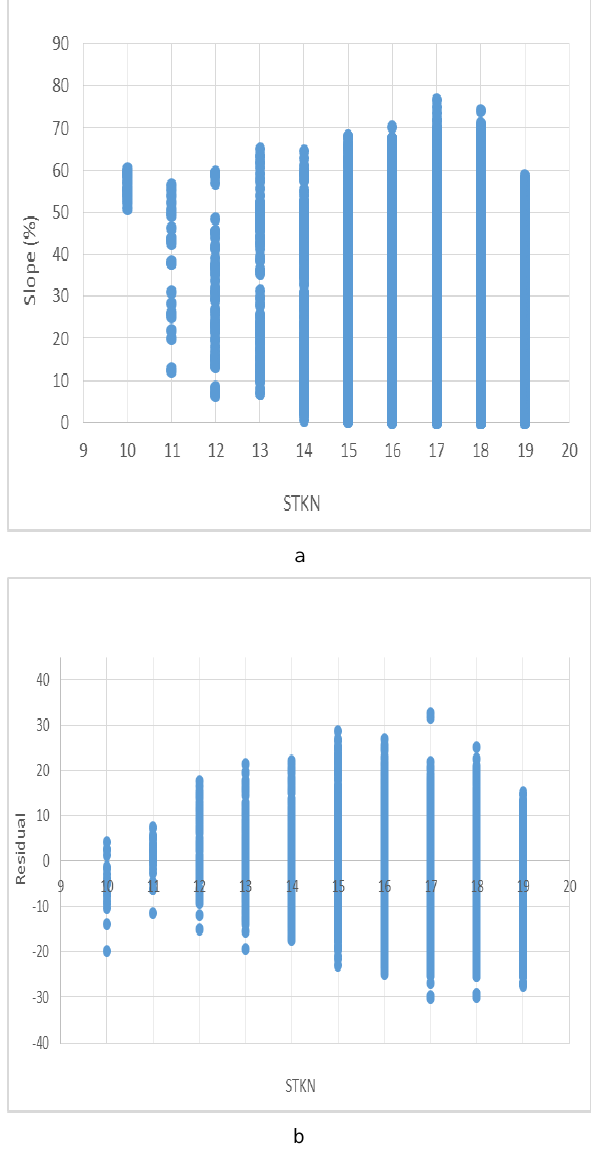
Figure 5. The scatter plot of a) Slope vs STKN, and b) Residual vs STKN in Tazehabad study area The relationship between residual and STKN in both study areas has shown that there is no strong correlation between these two parameters. One of reasons about this issue is that the Figure 4. The scatter plot of a) Slope vs STKN, and b) Residual number of STKN is started from at least 10, which is quite high vs STKN in Bomehen study area number, whereas previous researches show that at least 3 value of STKN lead to significant degradation. In Tazehabad (Figure 5.a), with the increase of STKN, the error values are led to the under-estimation, whereas in Bomehen (Figure 4.a), this causes to over-estimation in estimating the error value. Although there is no certain reason for this event, the overall behaviour of data shows that the increase of STKN can change the error direction to under-estimation or over-estimation. Based on difference in number of cells for any STKN, it can be expected that there is no specific relationship between error range and mean absolute error. Figure 5 and results in Tables 1 and 2 confirm